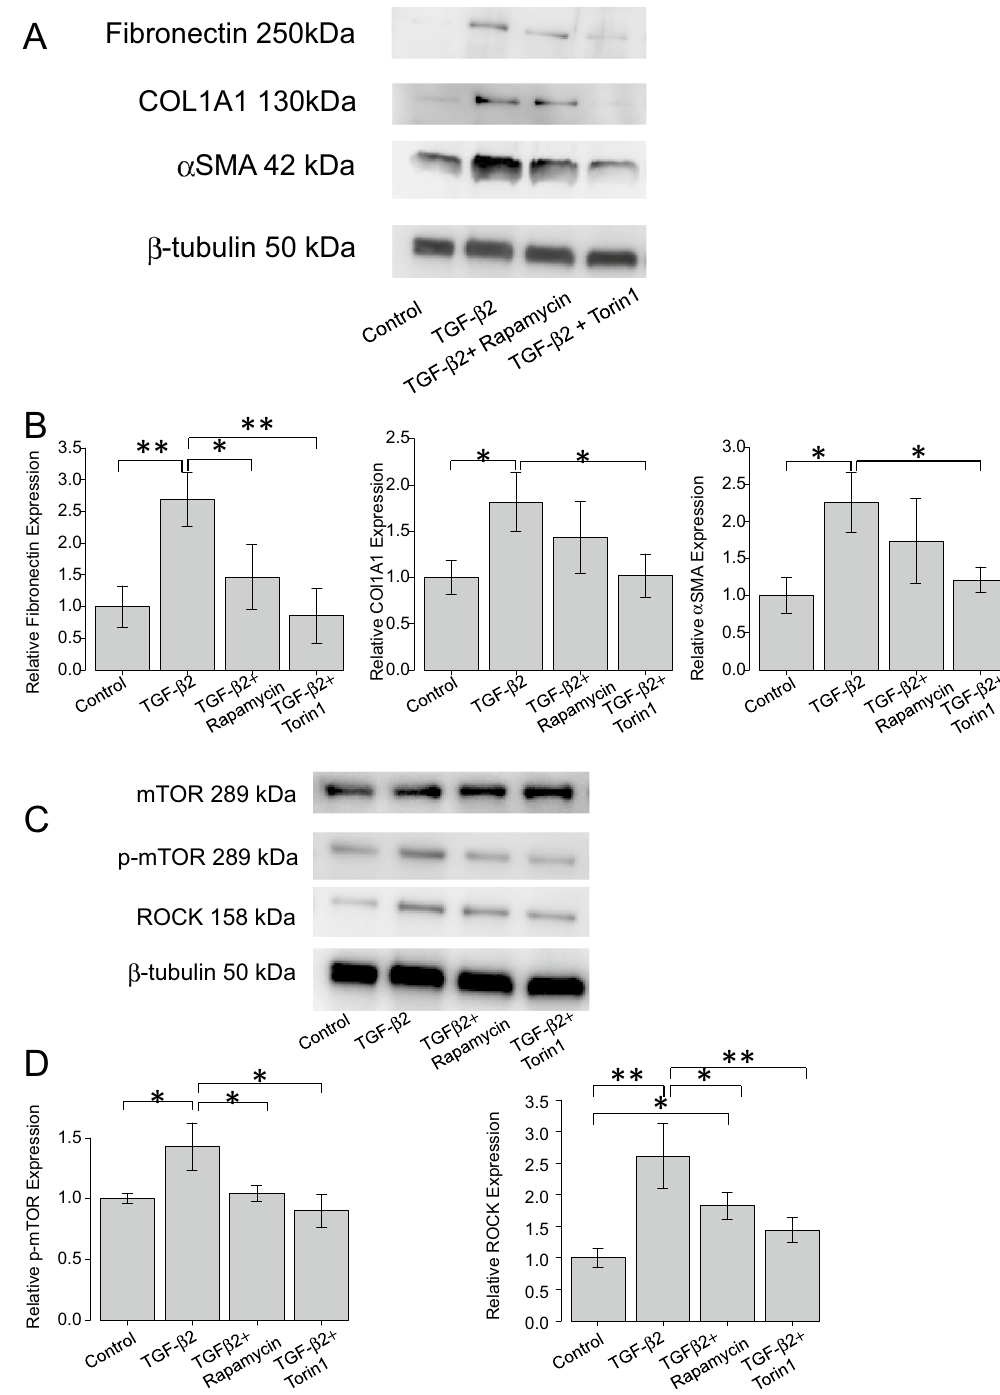
Figure 3. ( A ) and ( B ) Western blotting for fibronectin, COL1A1, F-actin, and αSMA in hTM cells. The representative bands for fibronectin, COL1A1, and αSMA are shown in ( A ), and the relative expression of fibronectin, COL1A1, and αSMA compared to the loading control (β-tubulin) are shown in ( B ) (n = 3). The various components were upregulated in hTM cells exposed to TGF-β2, and the fibrotic responses were significantly suppressed by the mTOR inhibitors rapamycin and Torin 1. One-way analysis of variance followed by the Tukey post-hoc test. *P < 0.05, **P < 0.01. ( C ) and ( D ) Western blotting for mTOR, phosphorylated mTOR and ROCK1 + ROCK2 in hTM cells. The representative bands for fibronectin, mTOR, phosphorylated-mTOR and ROCK1 + ROCK2 are shown in ( C ), and the relative expression of fibronectin, mTOR, phosphorylated- mTOR and ROCK1 + ROCK2 compared to the loading control (β-tubulin) are shown in ( D ) (n = 3). The various components were upregulated in hTM cells exposed to TGF-β2, and the fibrotic responses were significantly suppressed by the mTOR inhibitors rapamycin and Torin 1. One-way analysis of variance followed by the Tukey post-hoc test. *P < 0.05, **P <